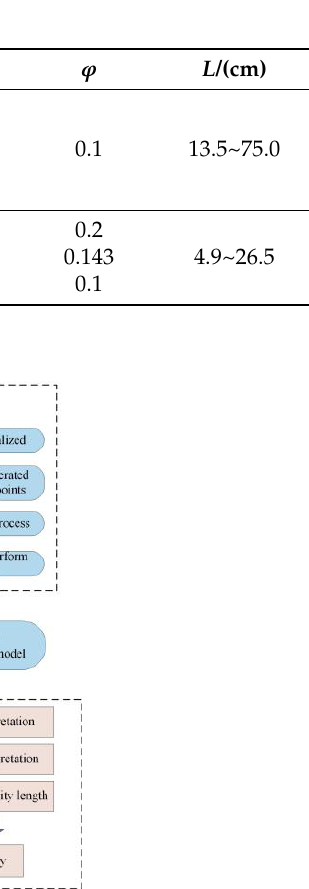
Figure 1. Schematic diagram of the spillway aerator and the formed cavity. Table 1. Parameter setting in the experiments.